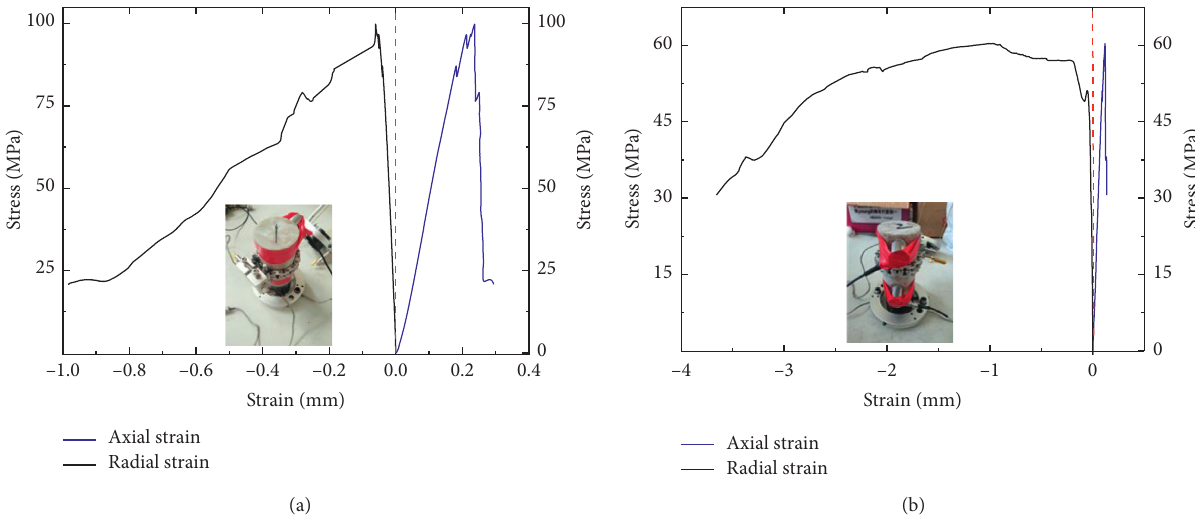
Figure 11: Uniaxial compression experiment of dolomite marble. (a) Dolomite marble sample 1. (b) Dolomite marble sample